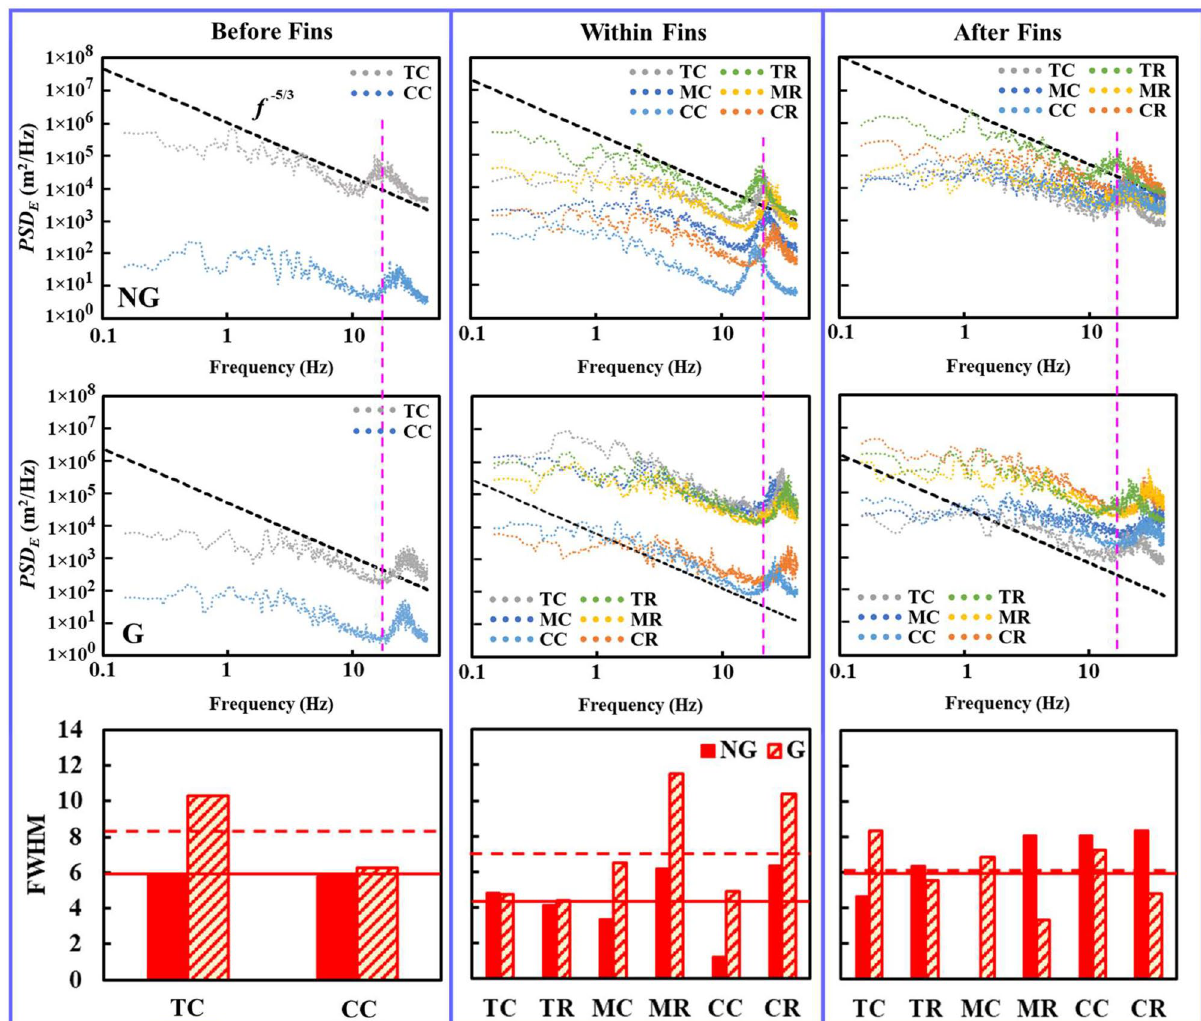
Figure 14. The 10-moving averaged equivalent PSD E (m 2 /Hz) of velocity fluctuations at Re Dh of 20.3 × 10 3 : top row: NG, middle: G, and bottom: the corresponding full width at half maximum of the peaks (FWHM). Vertical dashed reference lines illustrate the shift of spectra peaks between NG and